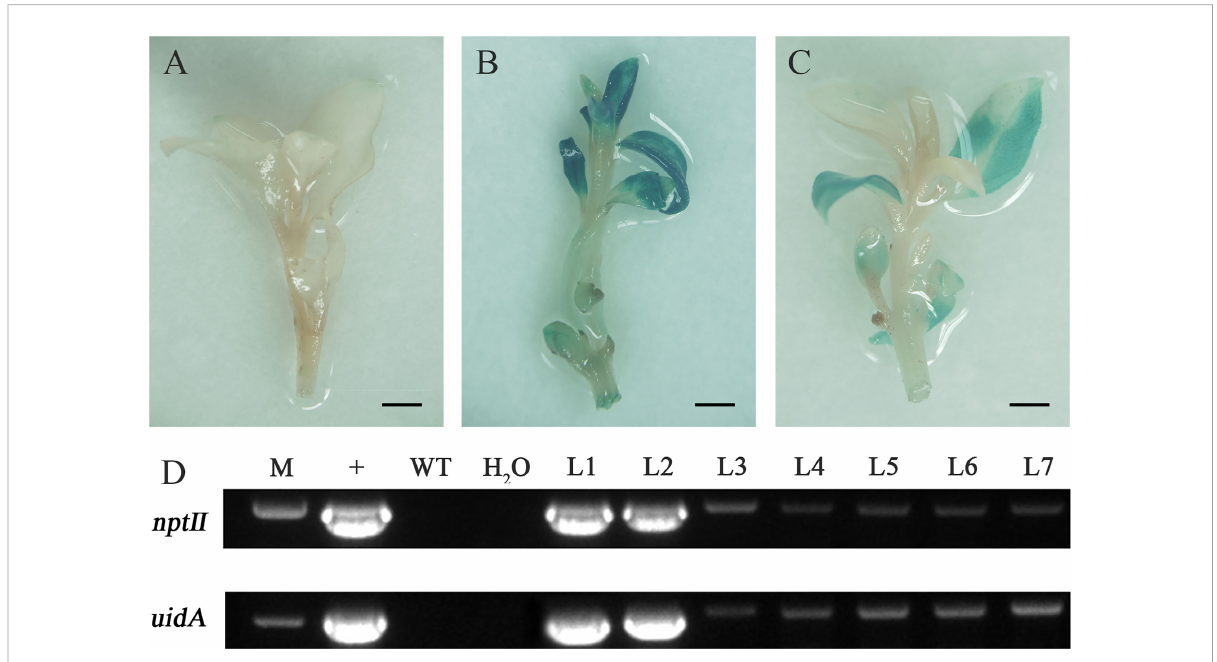
FIGURE 7 Molecular detection and b -glucuronidase (GUS) expression in transgenic plants. (A) Negative control. (B) and (C) GUS staining was observed in transgenic plants. (D) PCR ampli fi cation of the npt Ⅱ gene and uidA gene in pBI121: (M) marker, (+) plasmid, (WT) untransformed wild-type, (H 2 O) water control, and (L1-L7) transgenic lines. Scale bar: 0.25